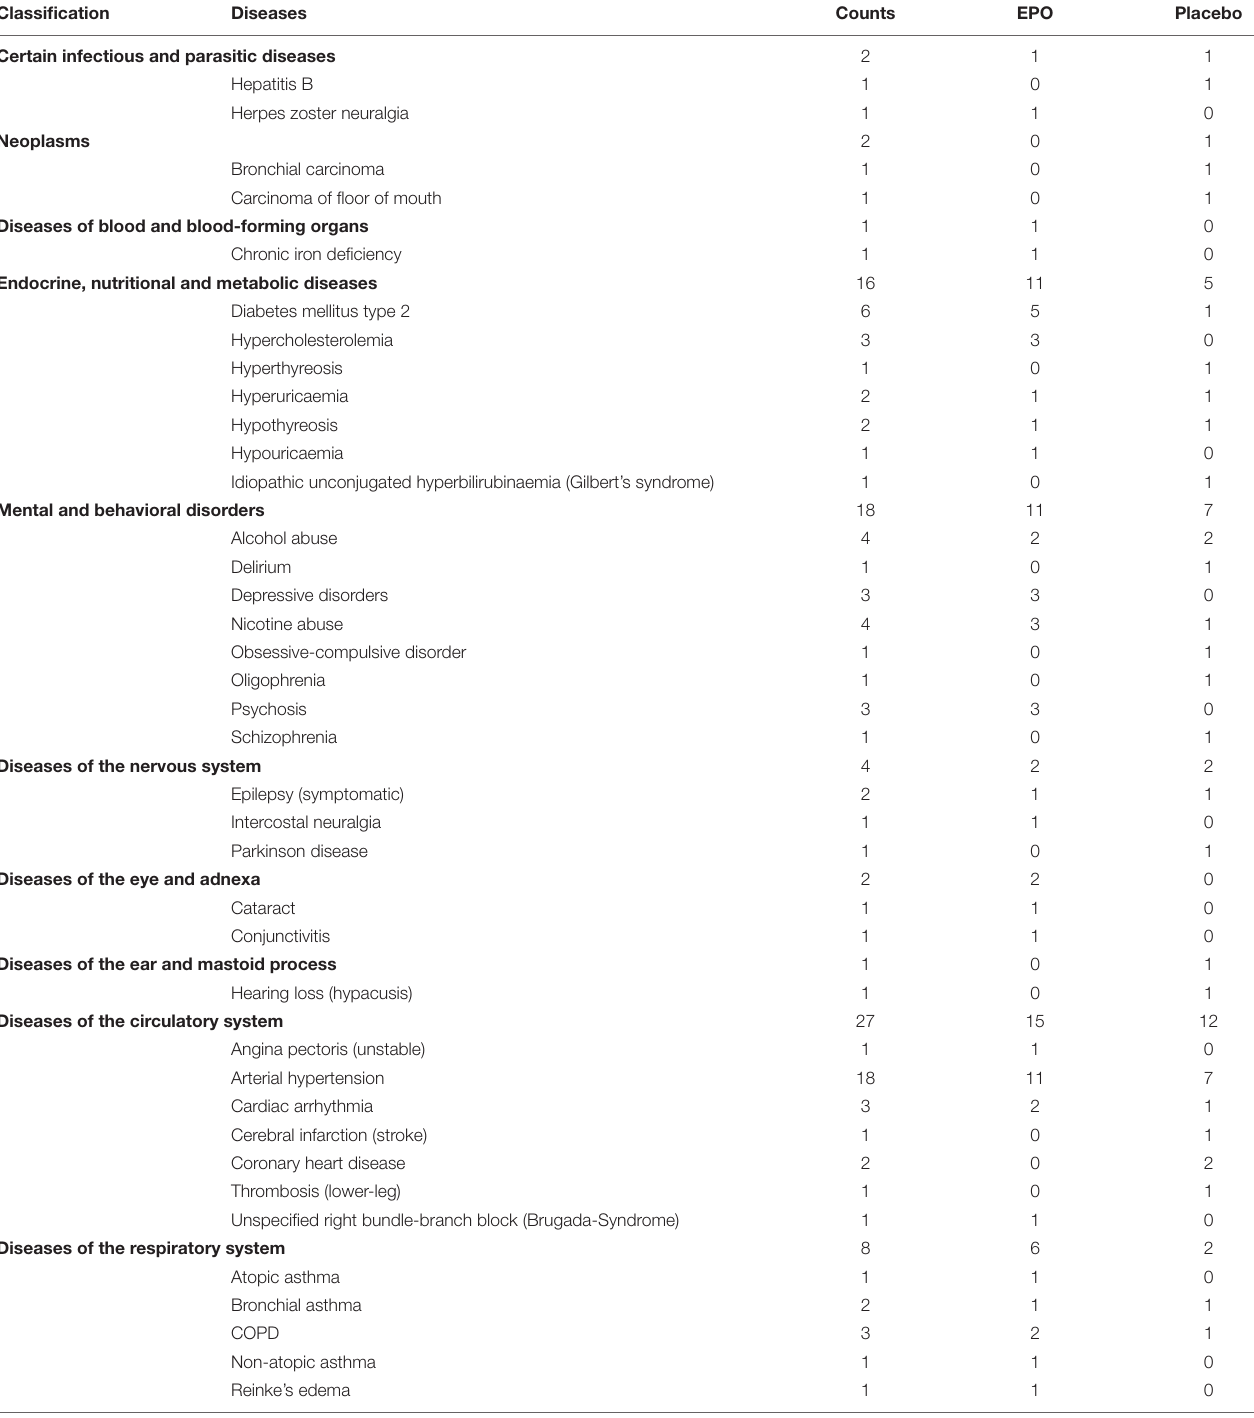
TABLE 3 | Concomitant diseases and injuries of ITT population (ICD-10 codes).